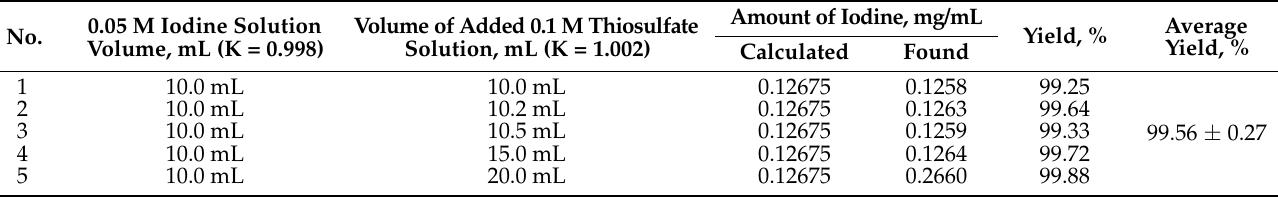
Table 2. The results of reduction